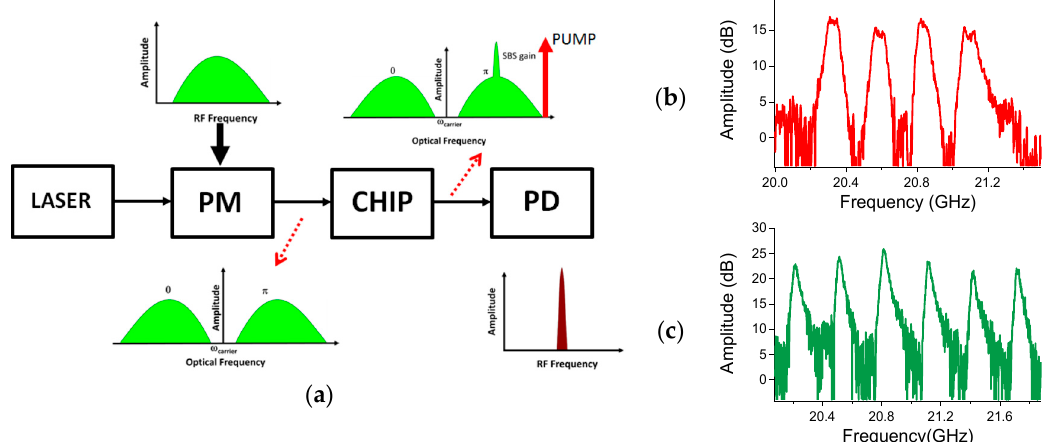
Figure 9. ( a ) Experimental setup of the SBS based multiband microwave phonic filter (courtesy of Dr. A. Choudhary). PM: phase modulator; CHIP: chalcogenide chip; PD: photodetector; AWG: arbitrary waveform generator. ( b , c ) Measured RF response with four and six passbands each separated by 250 MHz and 300 MHz, respectively (with the courtesy of Dr. A. Choudhary).